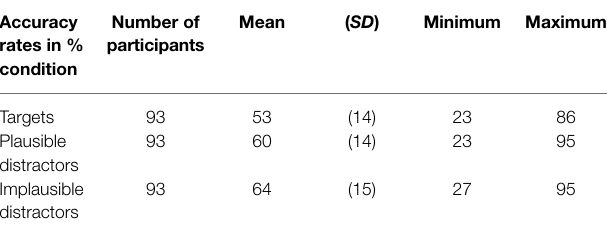
TABLE 3 | Accuracy rates by